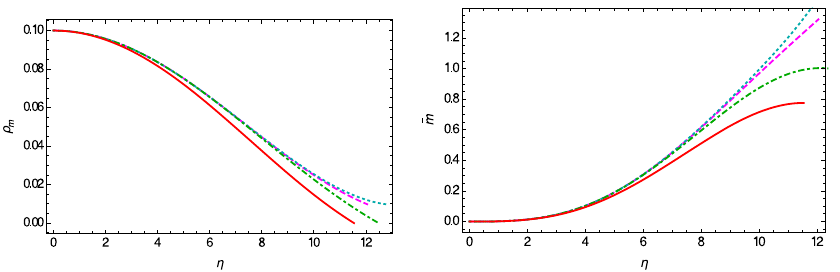
Fig. 25 Variations of the matter density profile ¯ ρ m (left panel) and of the mass profile ¯ m as functions of η for the three-form field Bose– Einstein condensate stars in the presence of a Higgs-type potential, for ¯ a = 0 . 001 and three different values of the constant ¯ b : ¯ b = 0 (dashed